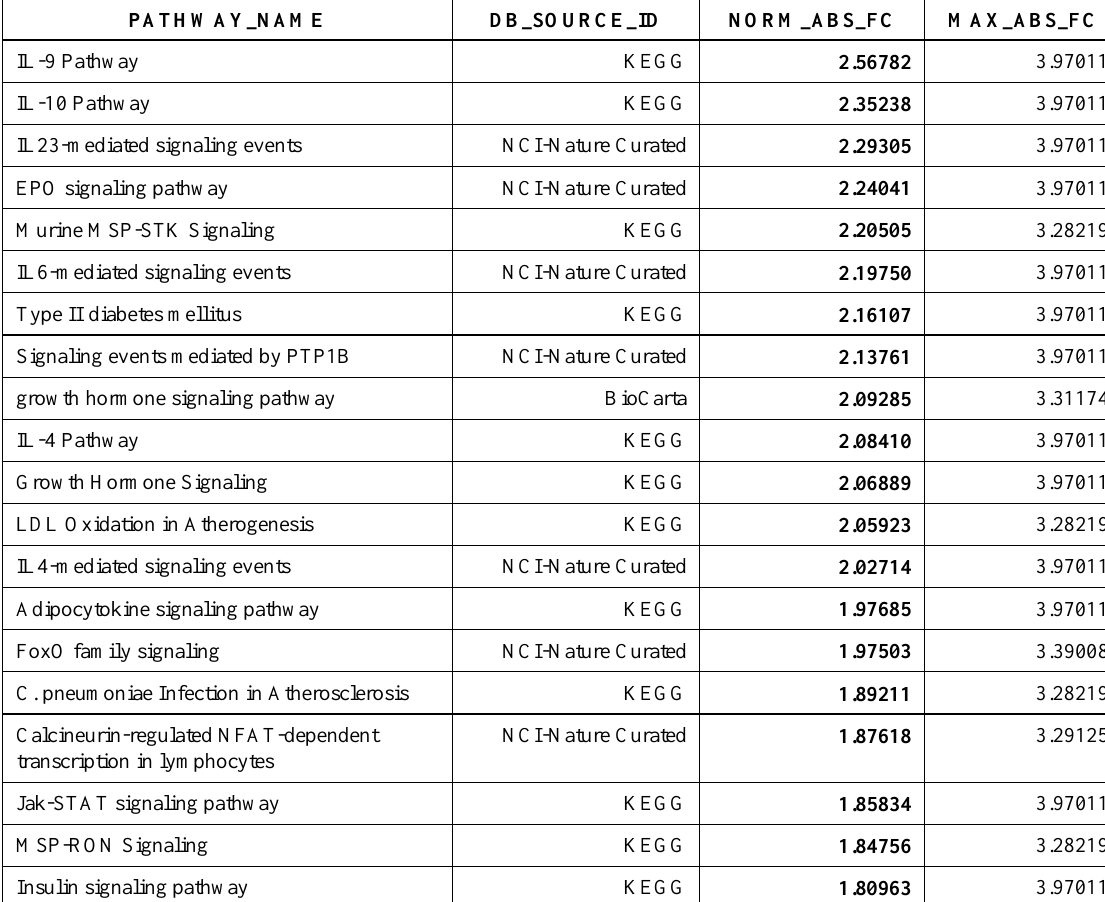
Table 3: Top-20 significant pathways in IBB from GSE24215, ordered by pathway differential expressions (p*-norm), which is measured with all the available differential gene expressions in IBB from